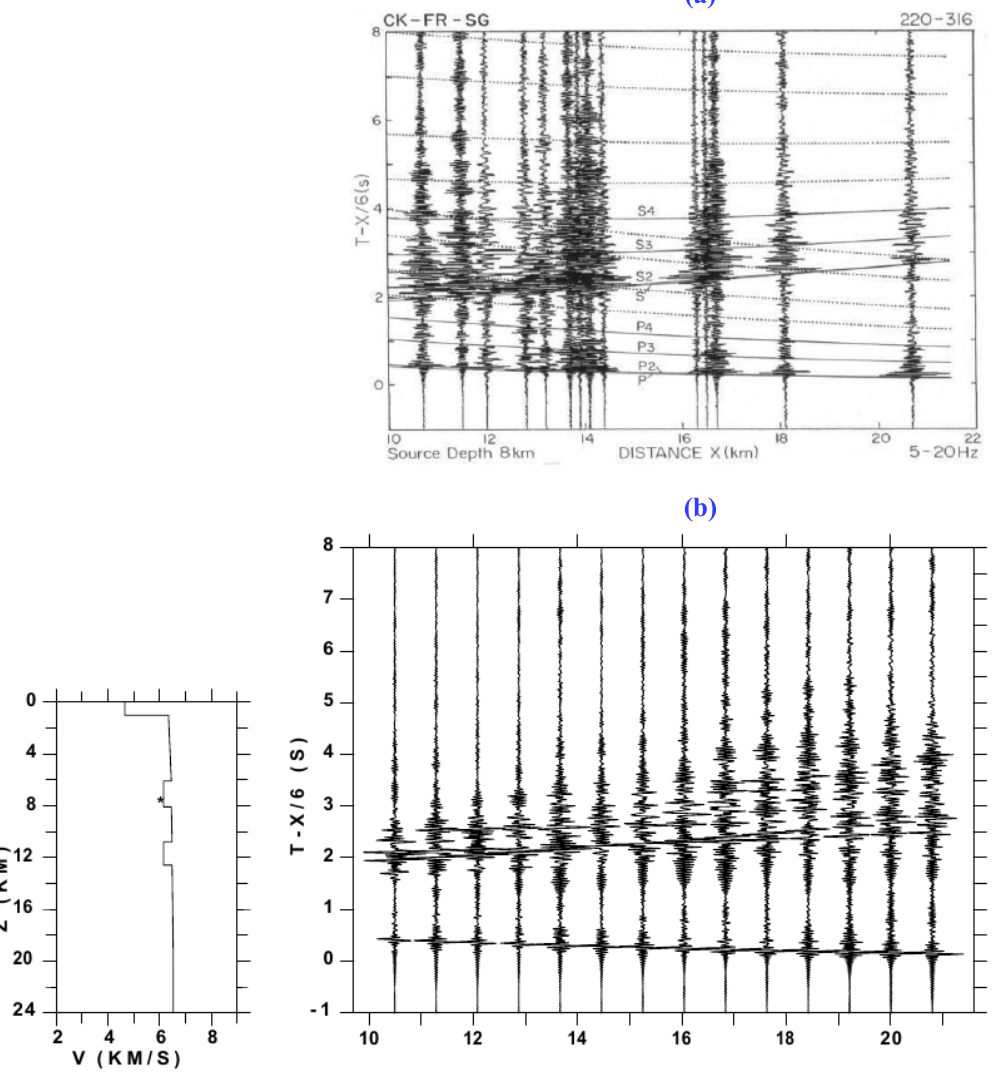
Figure 9. (a) Observed record section assembled from seismograms of local earthquakes with similar source mechanisms (the dominant mechanism is strike-slip), aligned to an average source depth of 8 km, and recorded at a combination of the seismograph stations CK, FR, and SG in the Koyna-Warna region. A reduction velocity of 6 km/sec is used for plotting. The amplitudes are trace-normalized. A band-pass filter 5-20 Hz is applied. Computed travel-time curves are shown for direct and refracted P and S phases, and primary reflection phases Pi and Si, as well as for the P and S phases leaving the source and reflected at the free-surface followed by reflection at an upper crustal bound- ary (unlabeled dotted curves in the time-increasing-order for reflections PfPi and SfSi, [i=1-4]). The seismograph stations and their azimuth range are indicated on the top of the record section. (b) Synthetic seismogram section computed by the reflectivity method for the virtual source parameters and using the inferred models of the upper crustal P and S velocity structure in the region. The amplitudes are trace-nor- malized. The left panel shows the P velocity